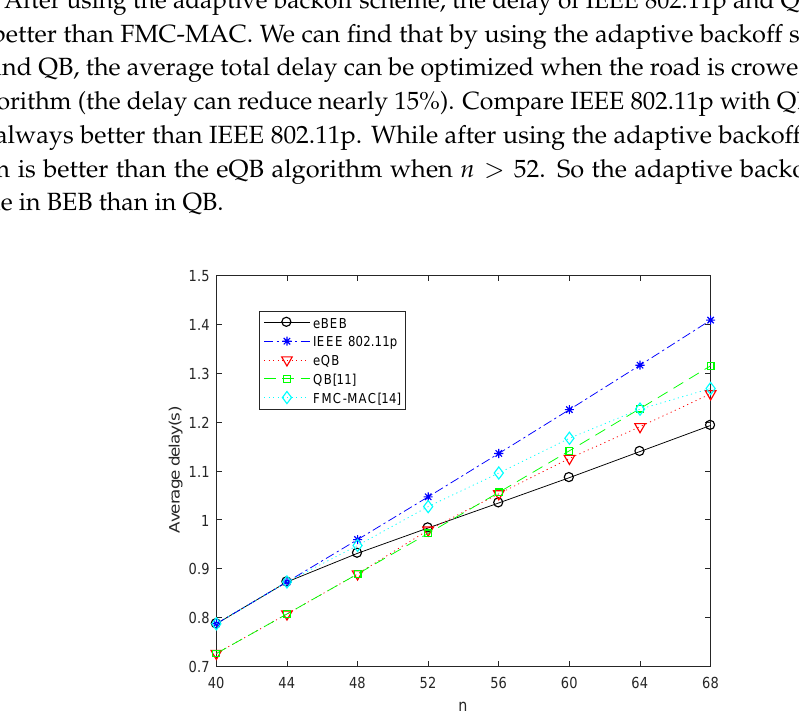
Figure 7. The optimal value of the average total